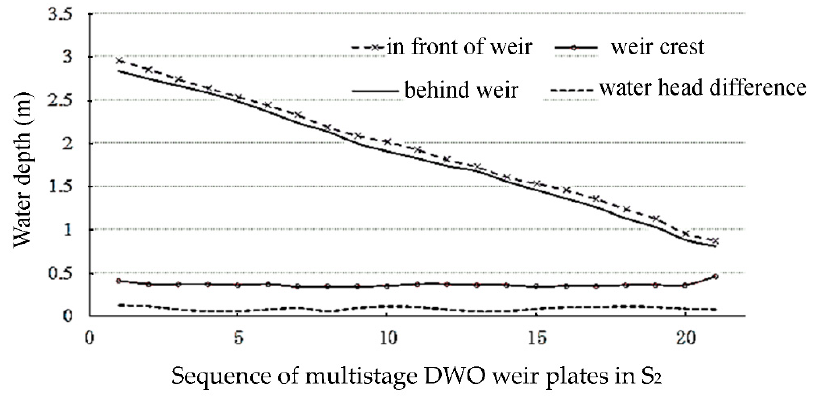
Figure 21. Change process of the water level along the transition reach. The water depth of the weir crest was reduced to 0.35 to 0.45 m and was quite uniform along the reach, almost presenting a horizontal line in the figure, which improved the fishway landscape. The water head drop of each stage was basically reduced to about 0.1 m, which contributed to fish migration in the upper layer.